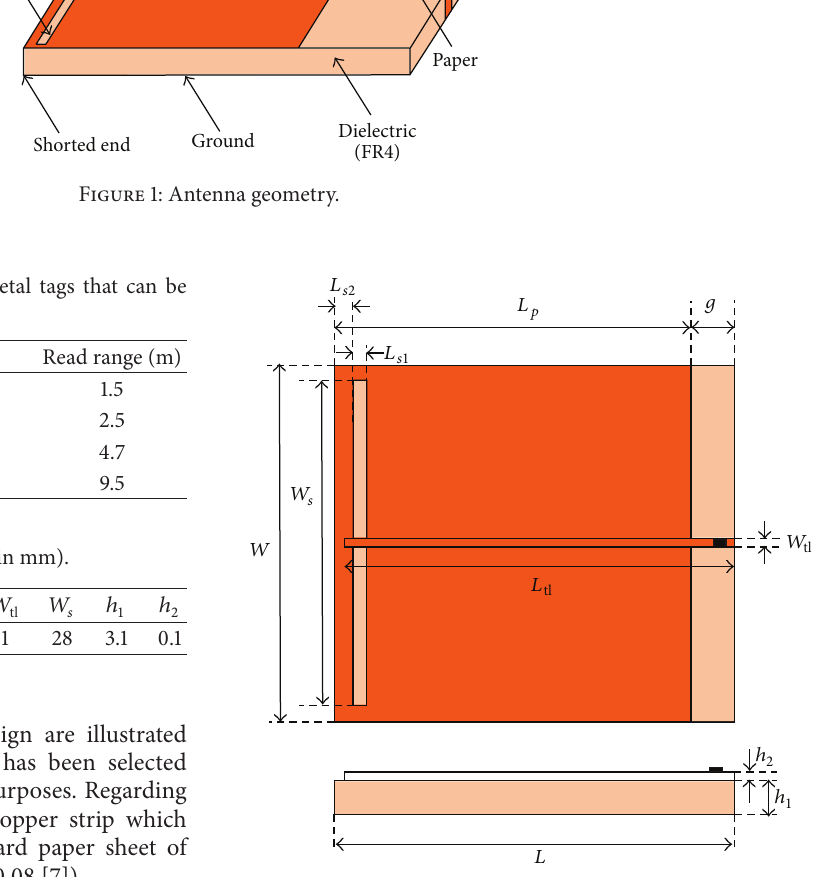
Figure 2: Antenna geometric parameters (top and front